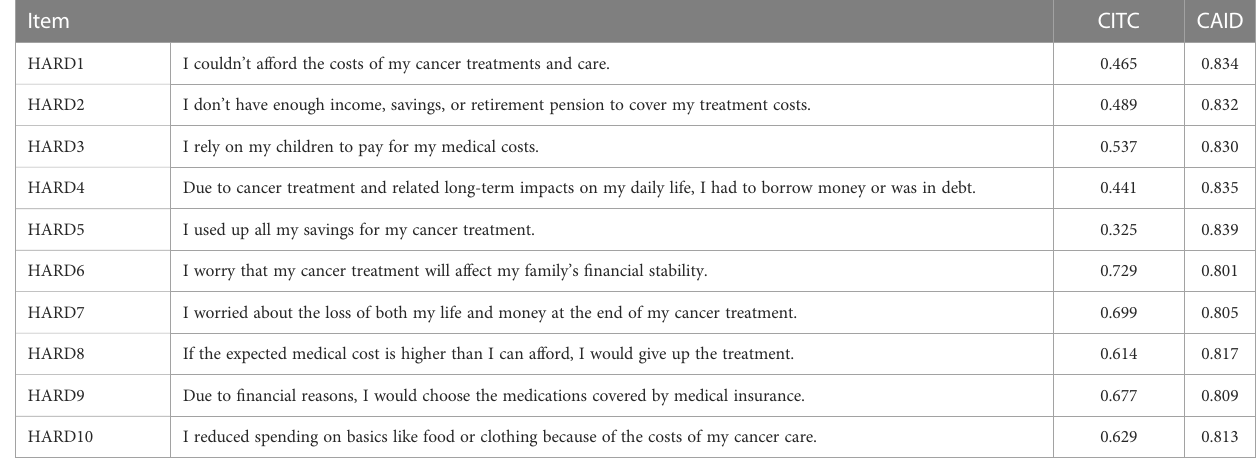
TABLE 3 Results of the reliability analysis.